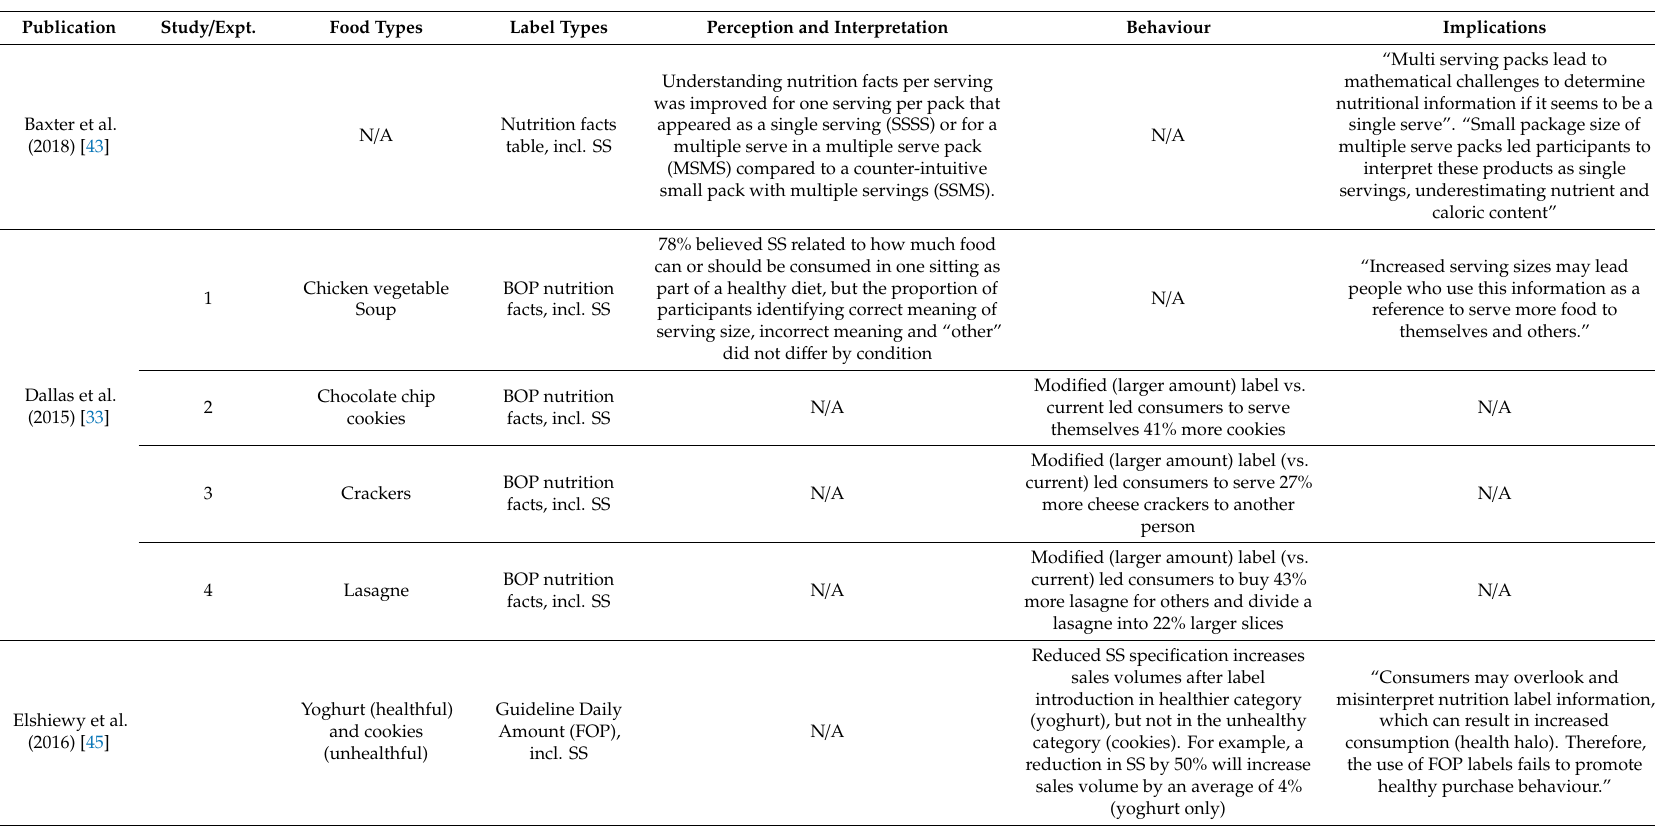
Table 2. Food label serving size information scoping review: summary of findings and